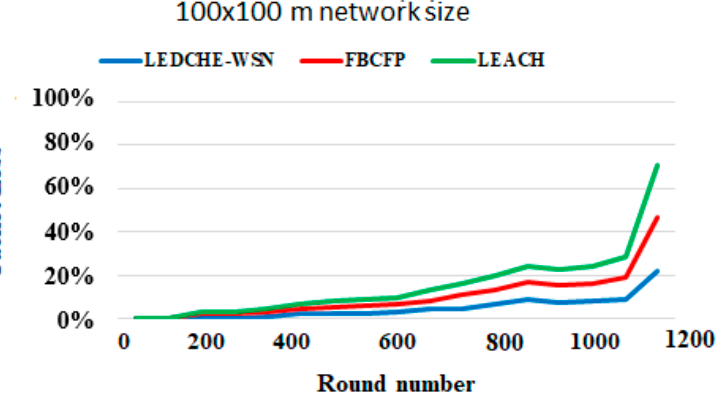
Figure 9. Percentage of packets loss ratio for the 100 × 100 m network size for LEACH, FBCFP, and LEDCHE-WSN protocols. LEDCHE-WSN